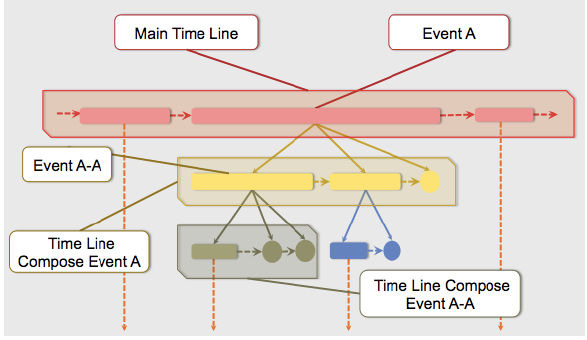
Figure 1. Examples of hierarchical structures of nested timelines. Timelines are composed of events and relationships among